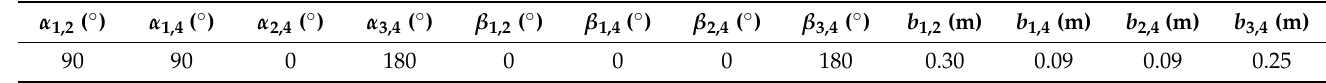
Table 2. Preselected attachment angles and post-attachment length of springs.